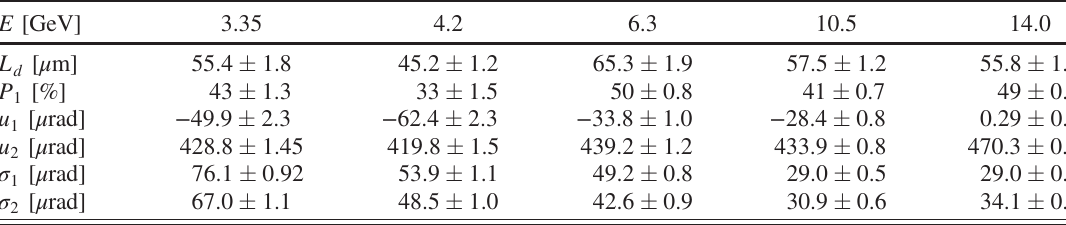
TABLE IV. A table of the fitting parameters for the crystal in “ channeling ” orientation using the described model.